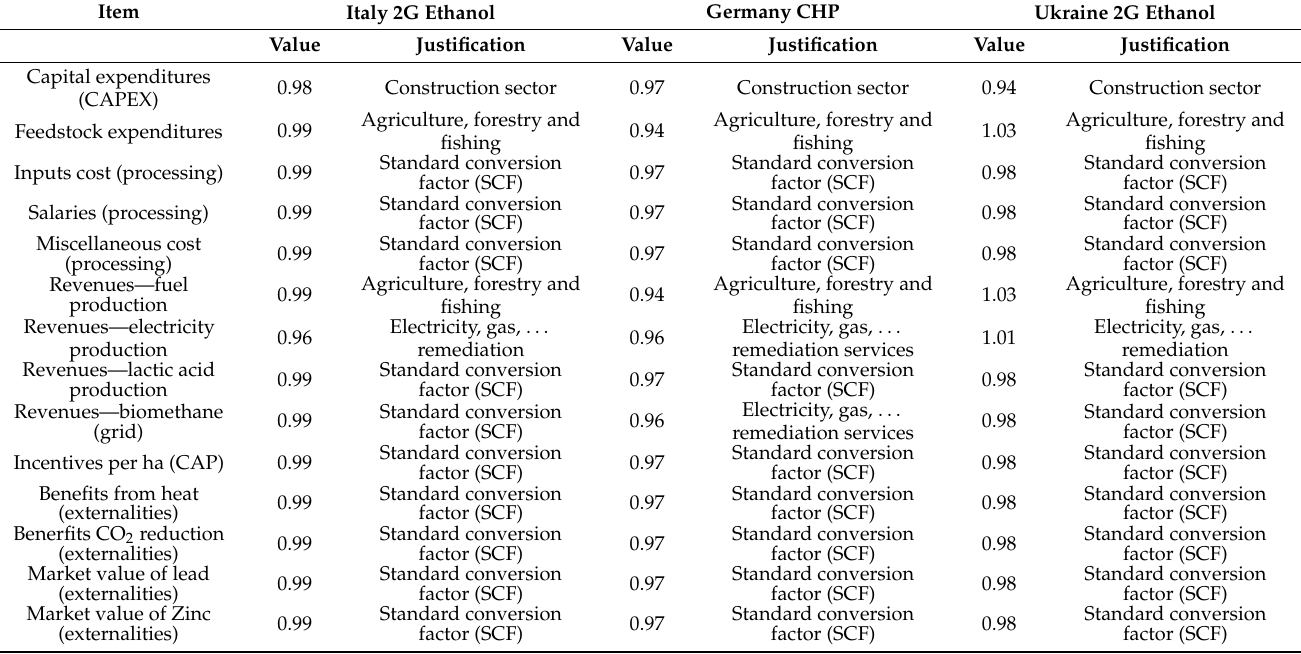
Table A1. Conversion factors for the economic analysis.